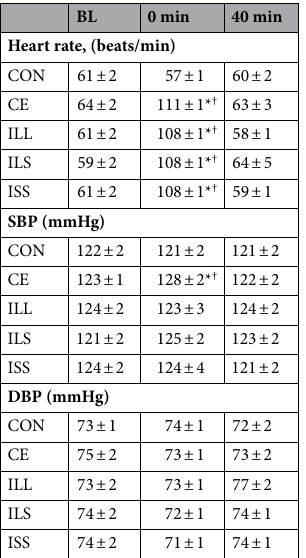
Table 2. Effects of continuous and intermittent exercise on heart rate and blood pressure ( n = 20). Values are mean ± SE. BL baseline, CON control, CE continuous exercise trial, ILL intermittent exercise of long bouts with long interval, ILS intermittent exercise of long bouts with short interval, ISS intermittent exercise of short bouts with short interval, SBP systolic blood pressure, DBP diastolic blood pressure. * P < 0.01 vs. BL; † P < 0.05 vs.